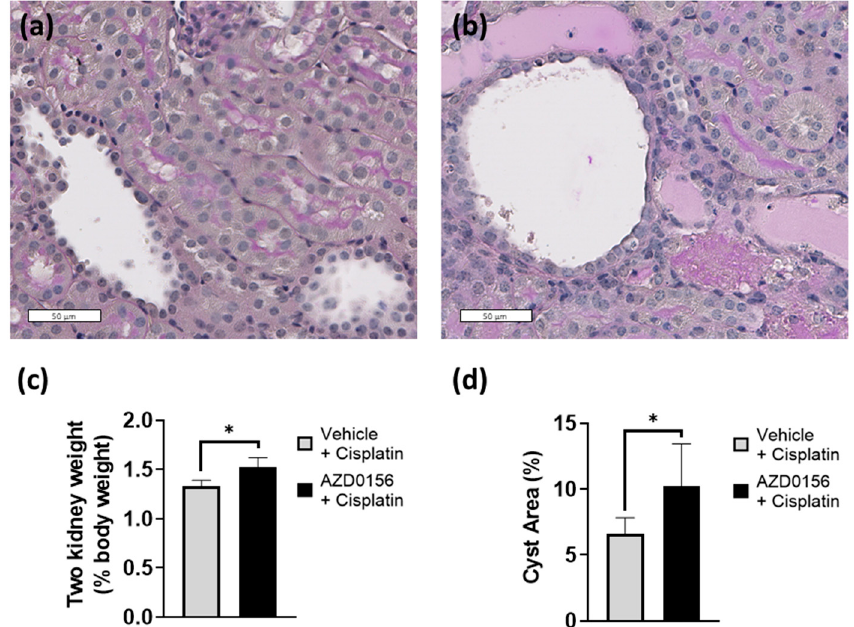
Figure 7. Pharmacological inhibition of ATM using AZD0156 increases tubular damage and cyst growth by 72 h in Pkd1 RC/RC mice. Morphology of outer cortical region of mice treated with cisplatin combined with ( a ) vehicle or ( b ) AZD0156. Histograms showing ( c ) two-kidney weight as a percent- age of body weight at sacrifice and ( d ) percentage cyst area in outer cortical region ( n = 4–5 per group). Graphs showing mean with error bars representing standard deviation; * p < 0.05. Scale bars = 50 µm.